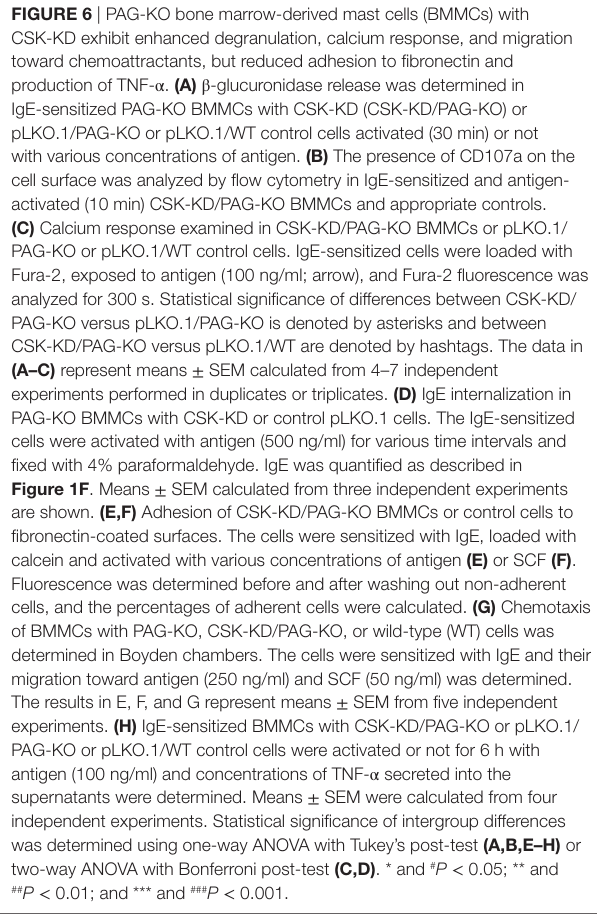
FigUre 6 | PAG-KO bone marrow-derived mast cells (BMMCs) with CSK-KD exhibit enhanced degranulation, calcium response, and migration toward chemoattractants, but reduced adhesion to fibronectin and production of TNF- α . (a) β -glucuronidase release was determined in IgE-sensitized PAG-KO BMMCs with CSK-KD (CSK-KD/PAG-KO) or pLKO.1/PAG-KO or pLKO.1/WT control cells activated (30 min) or not with various concentrations of antigen. (B) The presence of CD107a on the cell surface was analyzed by flow cytometry in IgE-sensitized and antigen- activated (10 min) CSK-KD/PAG-KO BMMCs and appropriate controls. (c) Calcium response examined in CSK-KD/PAG-KO BMMCs or pLKO.1/ PAG-KO or pLKO.1/WT control cells. IgE-sensitized cells were loaded with Fura-2, exposed to antigen (100 ng/ml; arrow), and Fura-2 fluorescence was analyzed for 300 s. Statistical significance of differences between CSK-KD/ PAG-KO versus pLKO.1/PAG-KO is denoted by asterisks and between CSK-KD/PAG-KO versus pLKO.1/WT are denoted by hashtags. The data in (a–c) represent means ± SEM calculated from 4–7 independent experiments performed in duplicates or triplicates. (D) IgE internalization in PAG-KO BMMCs with CSK-KD or control pLKO.1 cells. The IgE-sensitized cells were activated with antigen (500 ng/ml) for various time intervals and fixed with 4% paraformaldehyde. IgE was quantified as described in Figure 1F . Means ± SEM calculated from three independent experiments are shown. (e,F) Adhesion of CSK-KD/PAG-KO BMMCs or control cells to fibronectin-coated surfaces. The cells were sensitized with IgE, loaded with calcein and activated with various concentrations of antigen (e) or SCF (F) . Fluorescence was determined before and after washing out non-adherent cells, and the percentages of adherent cells were calculated. (g) Chemotaxis of BMMCs with PAG-KO, CSK-KD/PAG-KO, or wild-type (WT) cells was determined in Boyden chambers. The cells were sensitized with IgE and their migration toward antigen (250 ng/ml) and SCF (50 ng/ml) was determined. The results in E, F, and G represent means ± SEM from five independent experiments. (h) IgE-sensitized BMMCs with CSK-KD/PAG-KO or pLKO.1/ PAG-KO or pLKO.1/WT control cells were activated or not for 6 h with antigen (100 ng/ml) and concentrations of TNF- α secreted into the supernatants were determined. Means ± SEM were calculated from four independent experiments. Statistical significance of intergroup differences was determined using one-way ANOVA with Tukey’s post-test (a,B,e–h) or two-way ANOVA with Bonferroni post-test (c,D) . * and # P < 0.05; ** and ## P < 0.01; and *** and ### P <